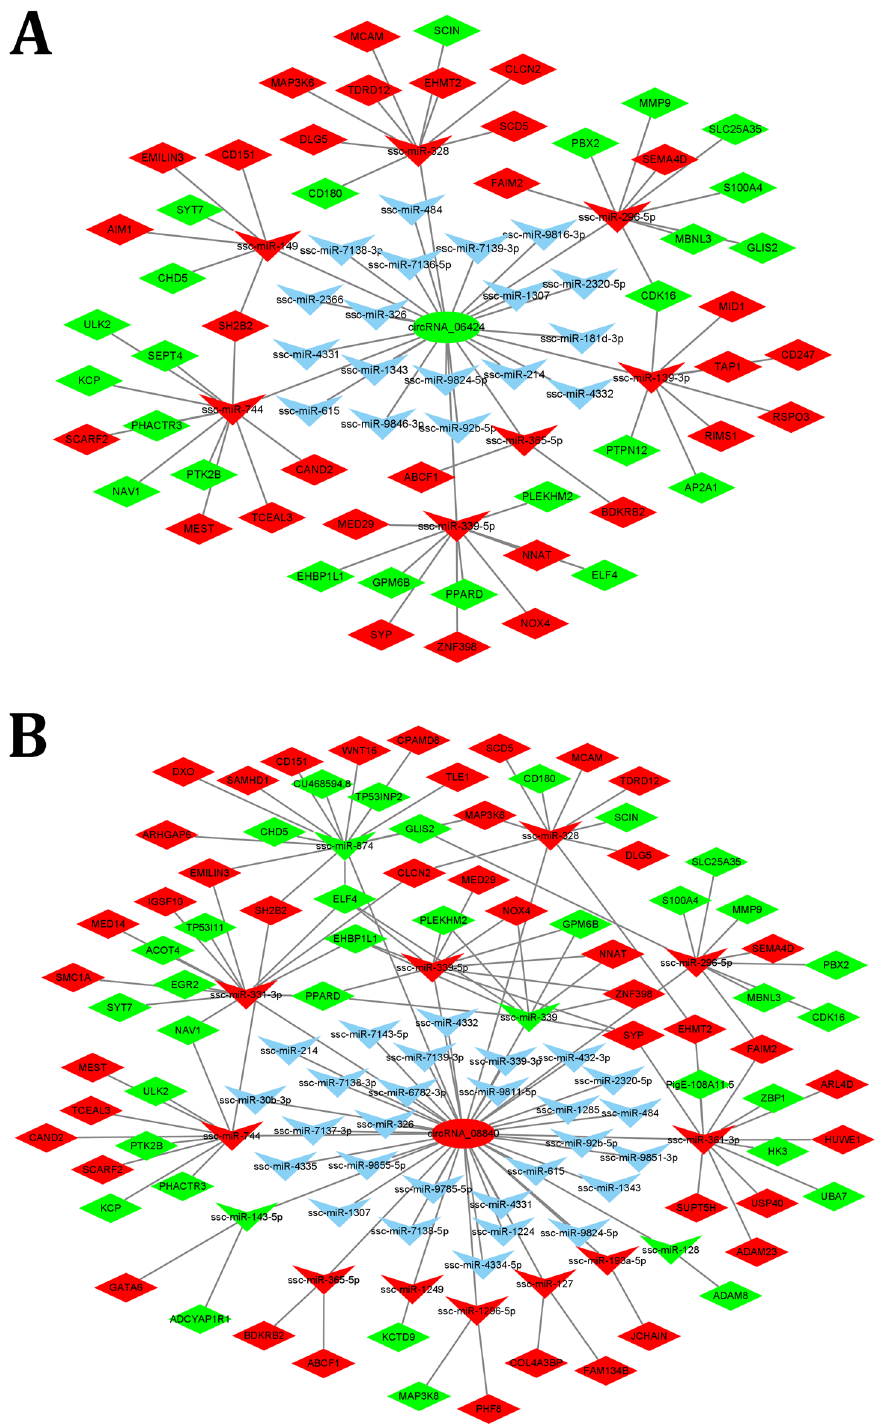
Figure 5. ceRNA networks of ( A ) circRNA_06424 and ( B ) circRNA_08840. Circle represents circRNA; triangle represents the miRNA; diamond represents gene; red represents up-regulation; green represents down- regulation; blue represents no